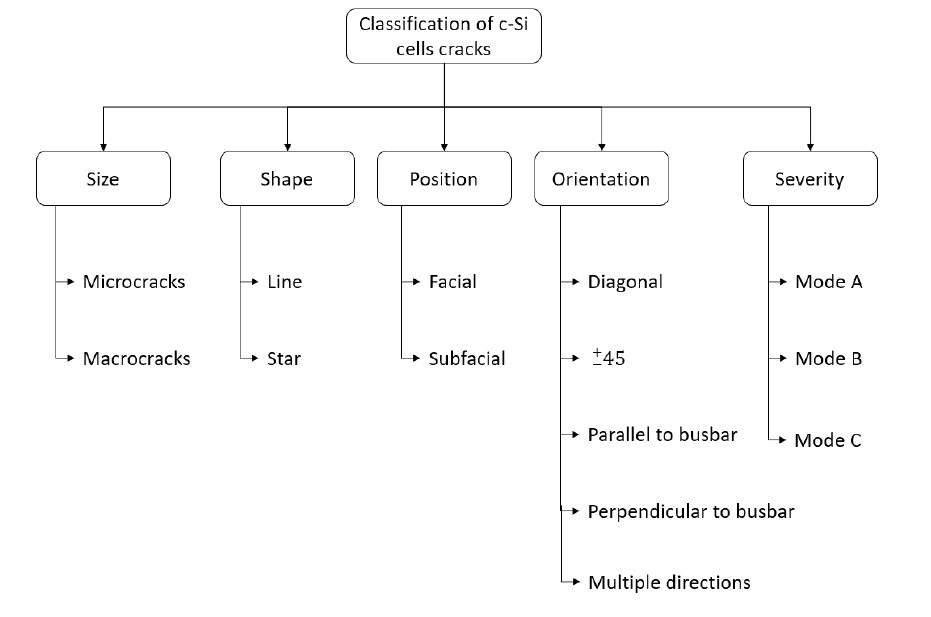
Figure 11. Classification of PV solar cell cracks according to the shape, directions, position, and severity of the cracks.